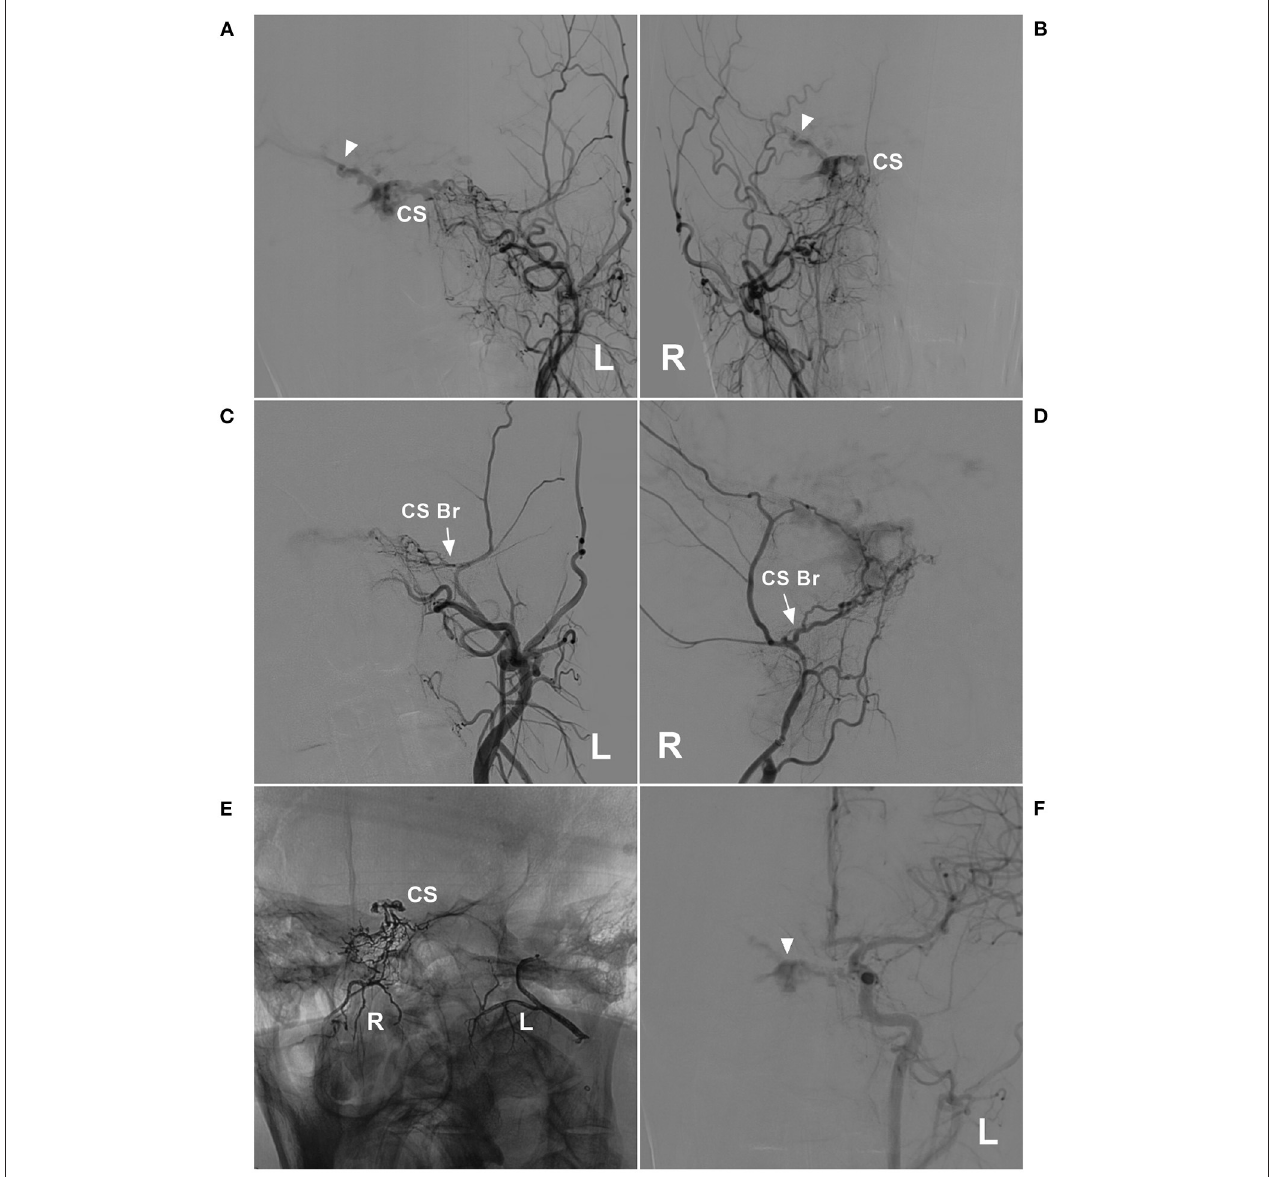
FIGURE 5 | Unsuccessful type Ia EVT of a CS DAVF. (A,B) : Left (A) and right (B) DSA of the anterior posterior view showed a CS DAVF with cortical vein drainage in the Sylvian fissure (triangles). (C,D) Left (C) and right (D) DSA showed the CS branch supplying the DAVF (arrows). (E) X-ray film showed bilateral embolization with Onyx. Onyx was successfully injected into the CS. (F) DSA of the left carotid artery showed that the EVT was incomplete, and the DAVF remained visible (triangle). Br, branch; CS, cavernous sinus; DAVF, dural arteriovenous fistula; DSA, digital subtraction angiography; EVT, endovascular treatment; L, left; R,